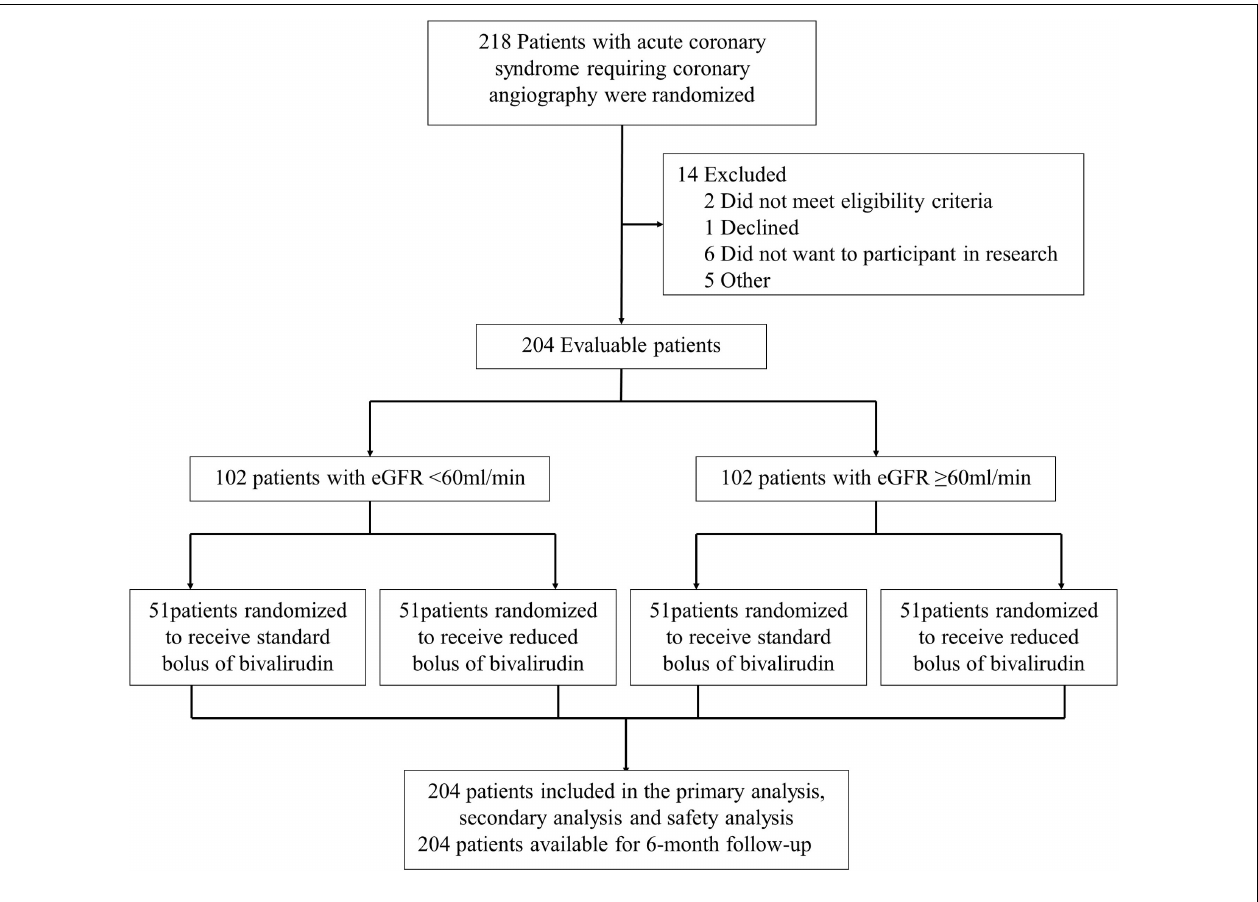
FIGURE 1 | Flow diagram of the study.